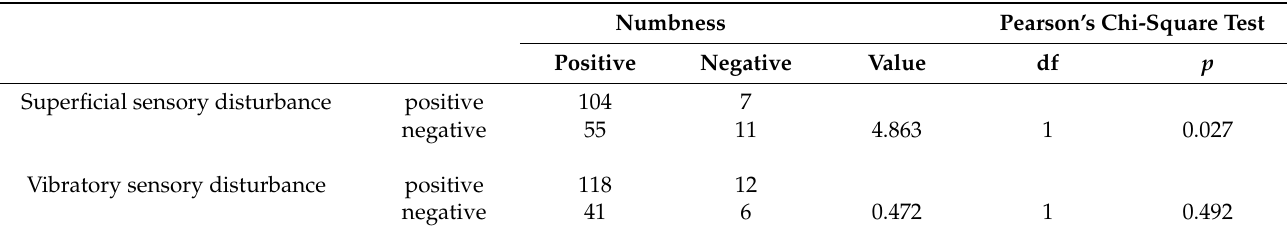
Table 3. Relationship between numbness and objective sensory